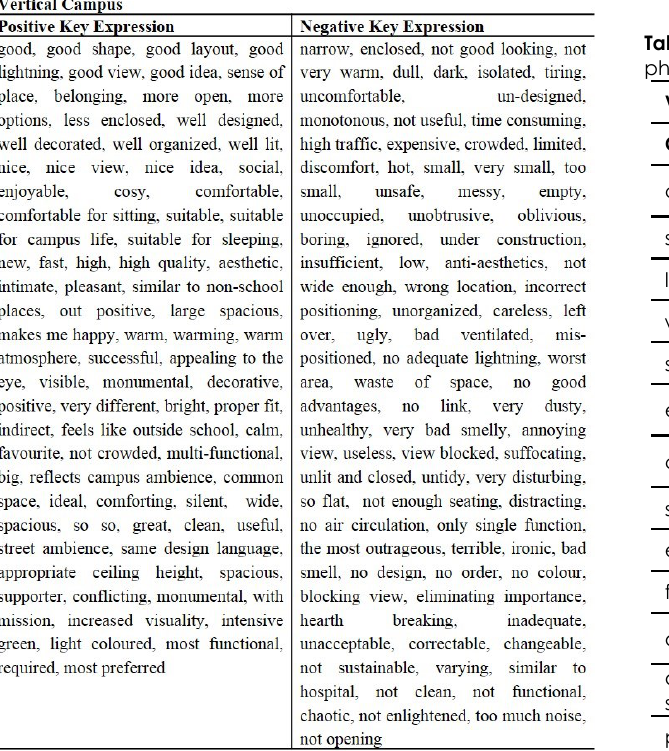
Table 4. Evaluative categories and key expressions from scene descriptions of vertical campus.